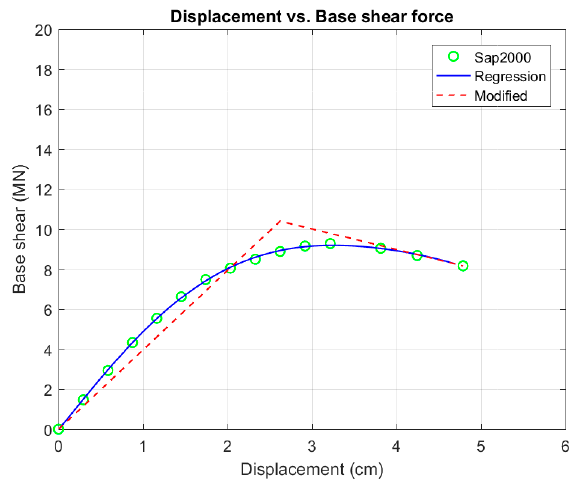
Figure 15. Example of yielding displacement for a pushover curve.